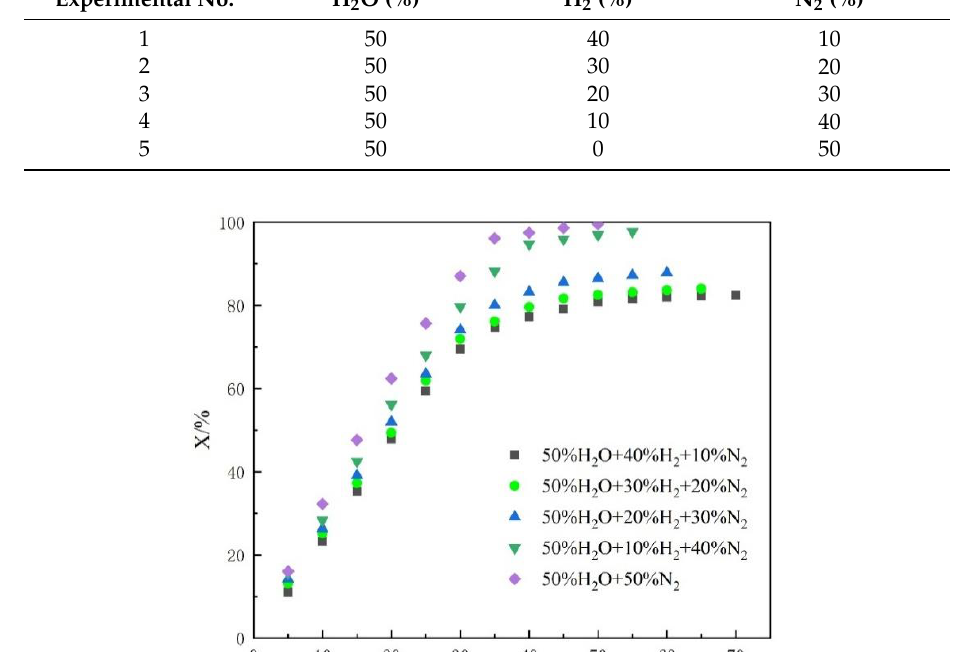
Figure 5. Carbon conversion degree curves of bituminous coal char at 1273 K in the mixture of H 2 O, H 2 and N 2 .